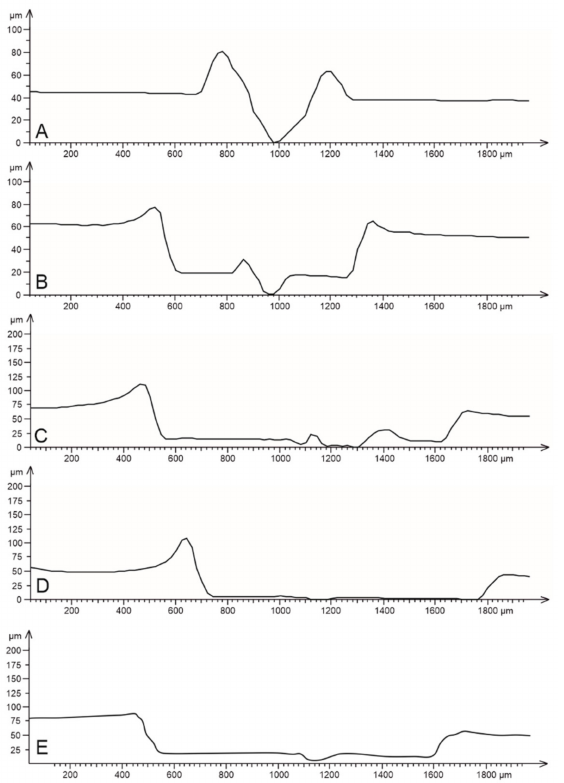
Figure 6. Extracted profiles from scratch surfaces. ( A ) Coat1, ( B ) Coat2, ( C ) Coat3, ( D ) Coat4, and ( E )